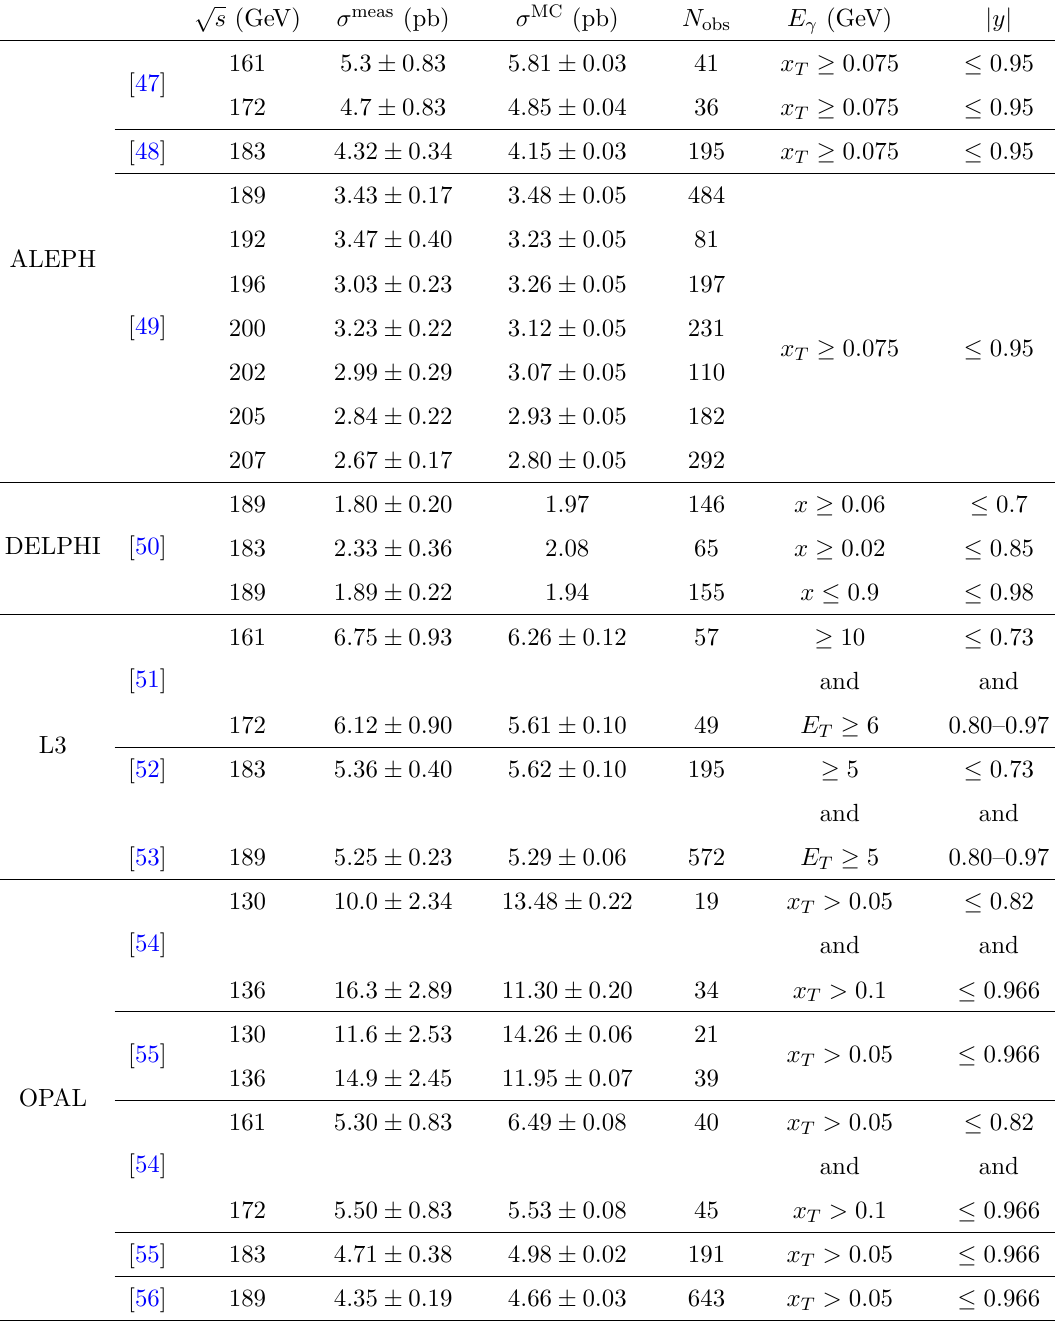
Table 2 . Data summary from the ALEPH, DELPHI, L3, and OPAL